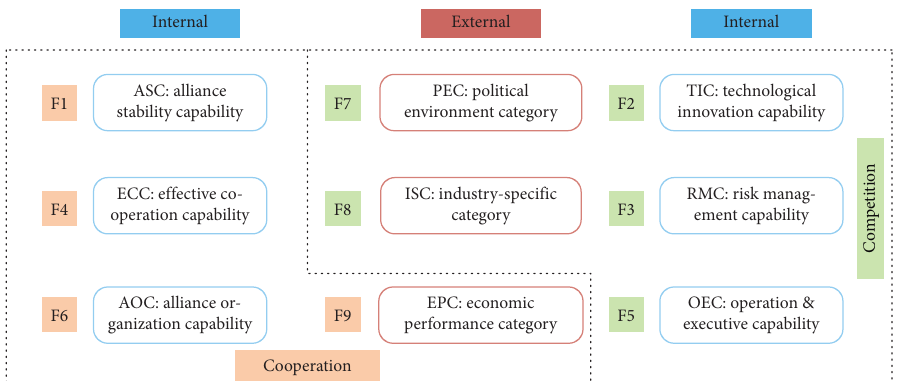
Figure 5: Diagram showing the relationships among the underlying